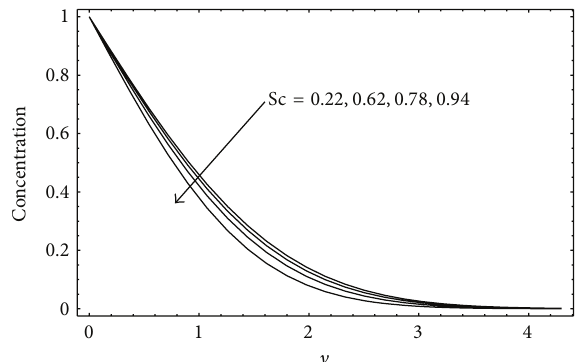
Figure 14: Temperature profiles for different values of 𝛾 when 𝑡 = 0.2, 𝑅 = 1 , and Pr = 0.71 .